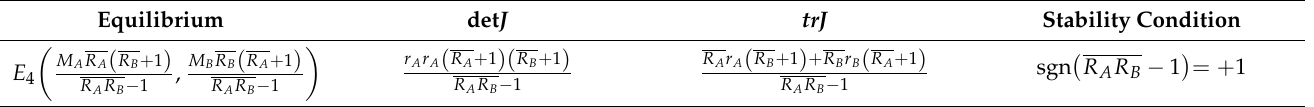
Table 5. Stability analysis of coexistence equilibrium in the cooperation symbiosis. Equilibrium Stability Condition